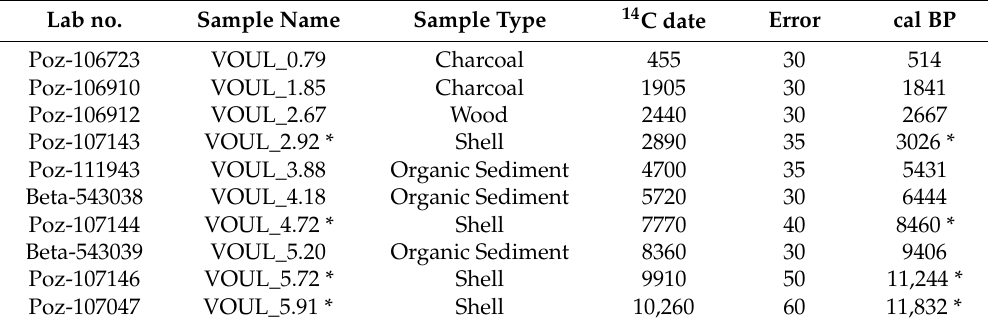
Table 1. List of radiocarbon samples from Lake Vouliagmeni core. Calibrated ages are presented in median values and were determined using IntCal13 calibration dataset [92]. * = Marine reservoir correction as suggested by [91]. Lab